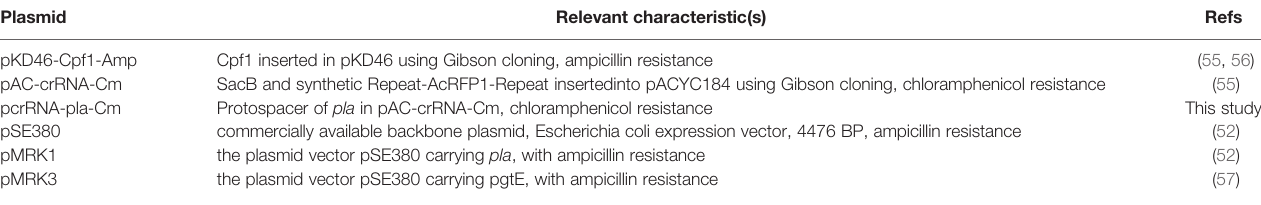
TABLE 3 | Plasmids employed in this study.